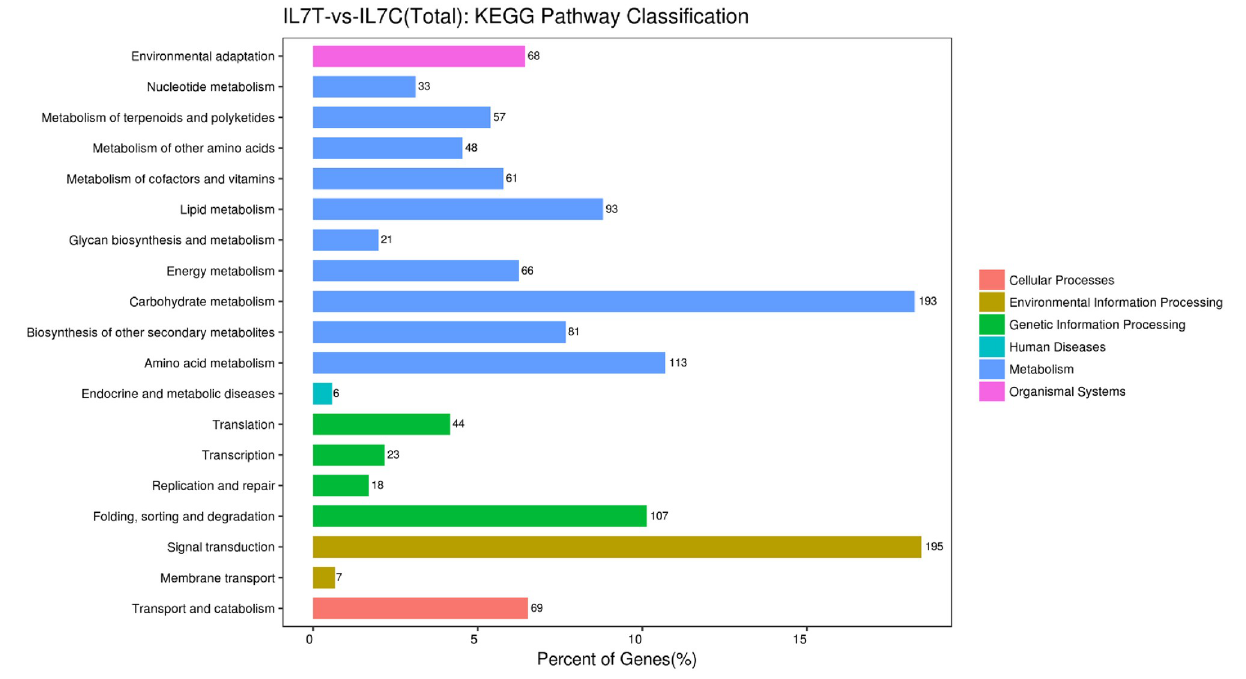
Fig 4. Functional classification of unigenes by using KEGG